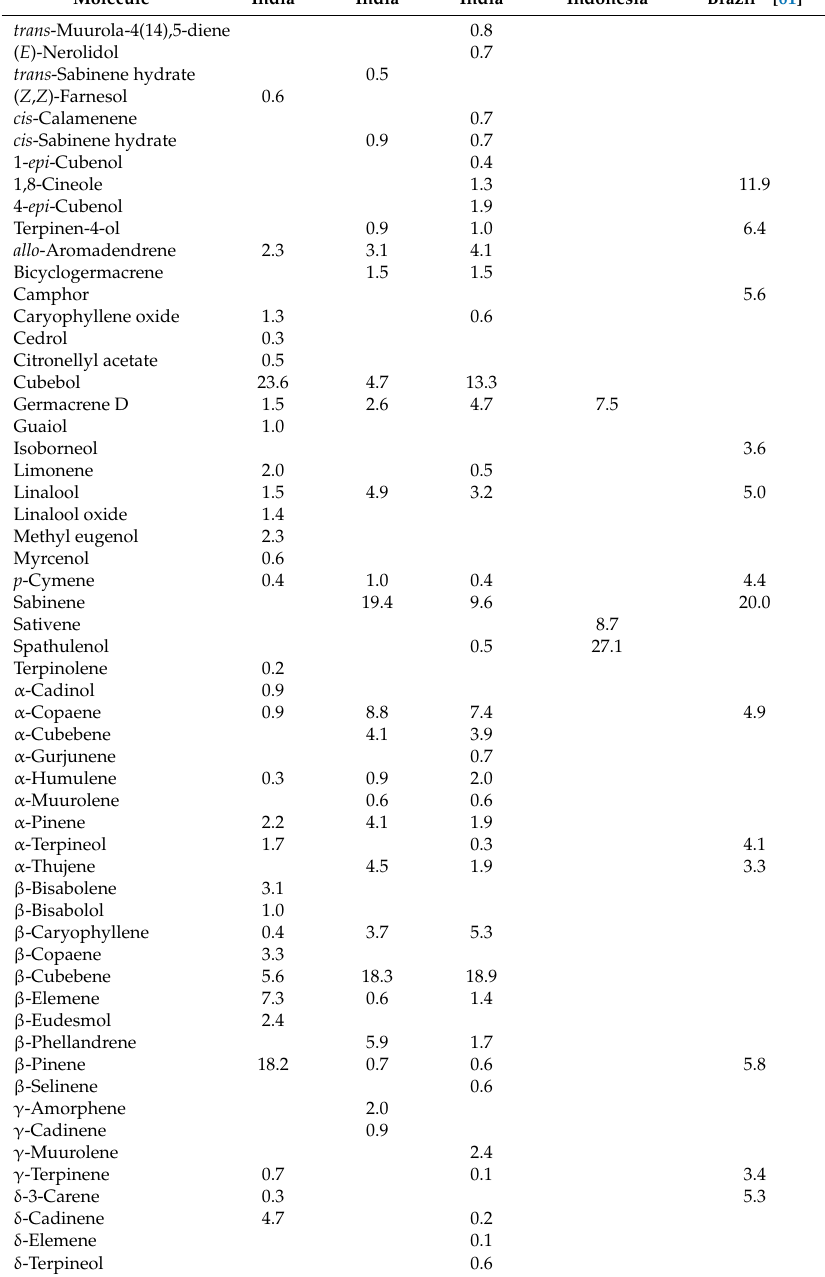
Table 9. Chemical compositions (%) of Piper cubeba fruit essential